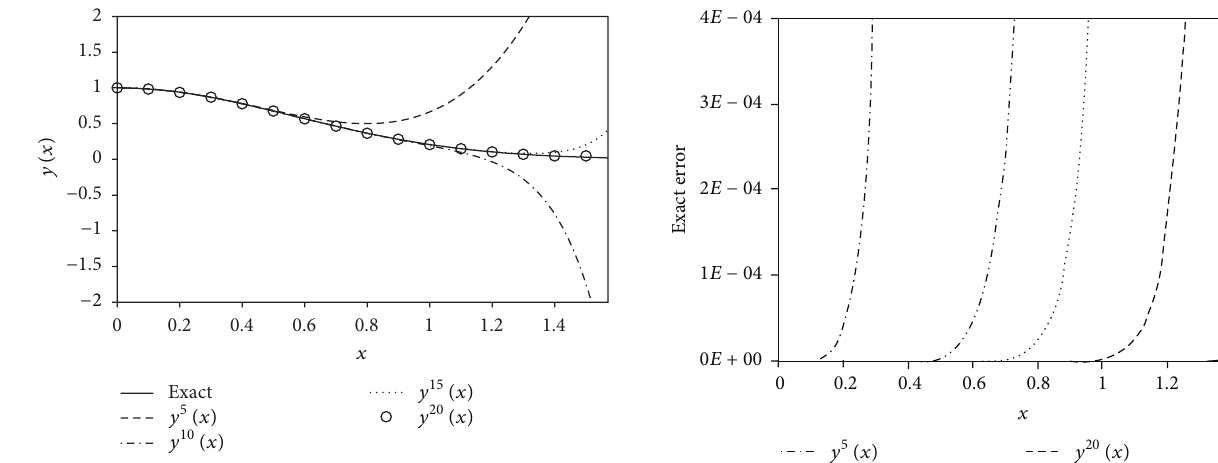
Figure 1: Plots of the RPS solution to (28) and (29) when 𝑘 = 5, 10, 15, 20 and the exact solution is on [0,𝜋/2] .